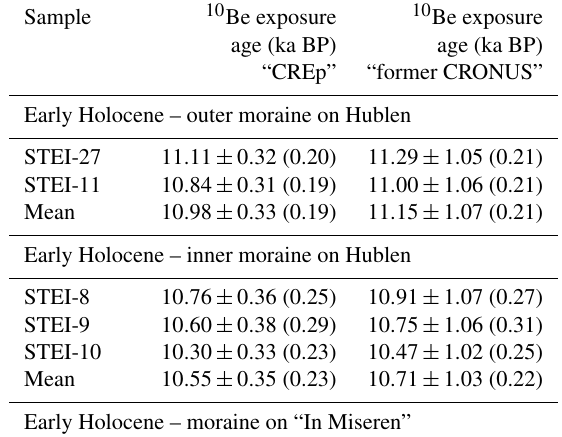
Table 3. 10 Be moraine ages and apparent 10 Be bedrock ages at Steingletscher, with their full 1 σ uncertainties. The uncertainties in parentheses are the analytical 1 σ uncertainties in the case of individ- ual ages and standard deviations in the case of mean ages. Moraine ages are recalculated from Schimmelpfennig et al. (2014), using the same methods as for the bedrock samples (see Sect. 3.4). One out- lier is in italics. The apparent 10 Be exposure ages do not account for subglacial erosion effects and are therefore minimum ages (with reference to the year of sampling). All moraine ages and bedrock ages from Hublen are referenced to